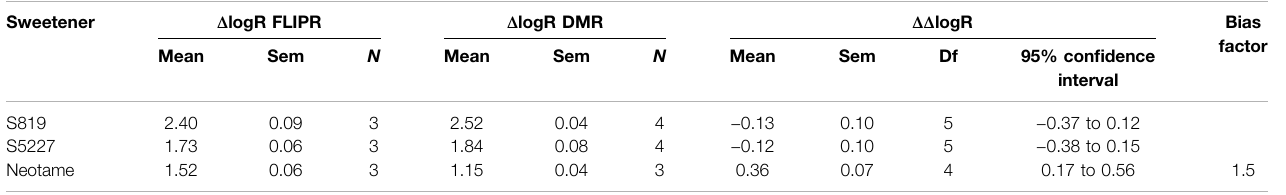
TABLE 3 | Transduction coef fi cients, Δ logR and ΔΔ logR values obtained from dose-response FLIPR-G α 16gust25 and DMR data fi tting using the operational model. Ligand bias was estimated as described in Materials and Methods . Sweetener